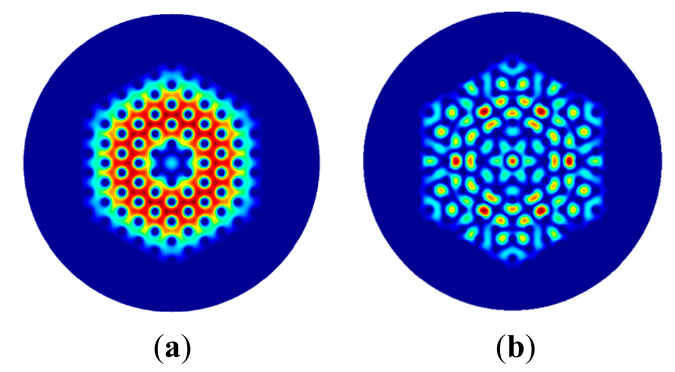
Figure 4. Norm of the electromagnetic field distribution at the pump wavelength of: ( a ) M 4 cladding mode; ( b ) M 21 cladding mode.